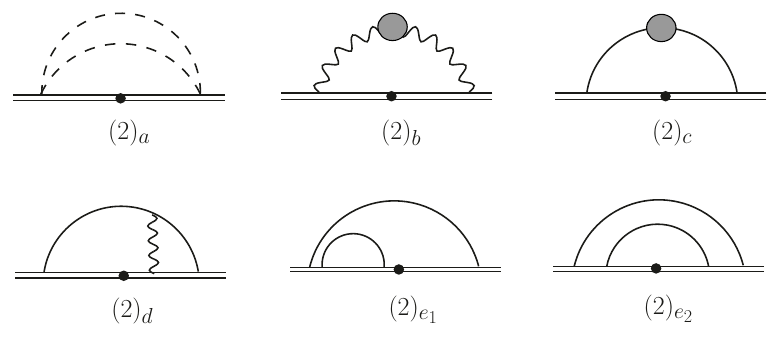
Figure 7 . Two-loop diagrams. Solid lines represent fermions, while dashed lines correspond to scalars. Wave lines are gauge vectors, as